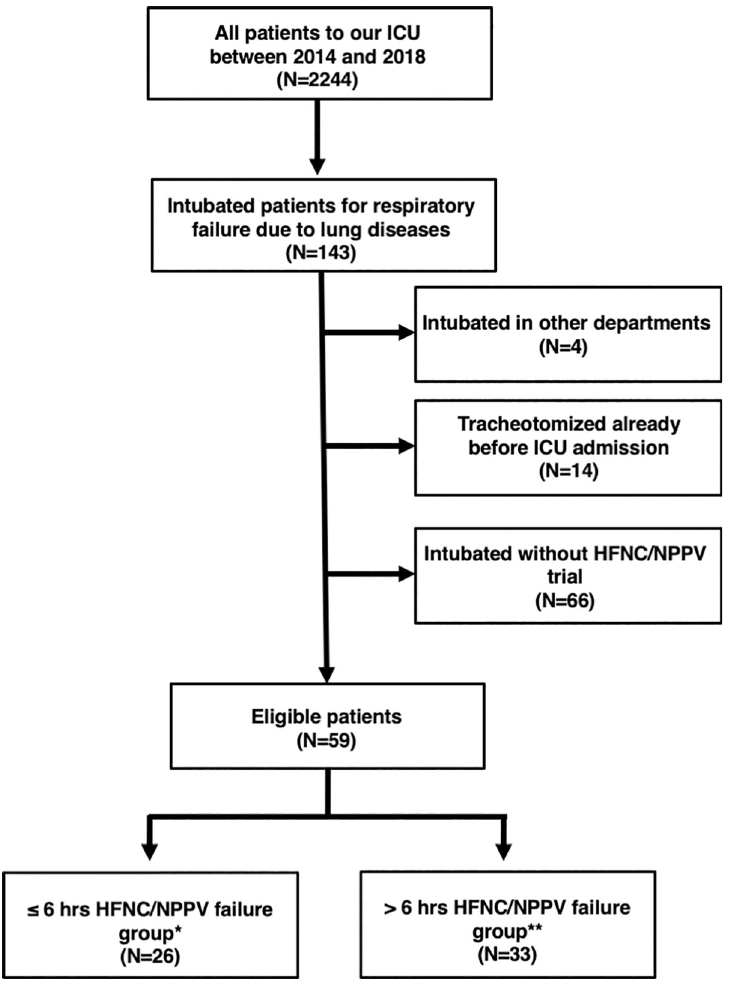
Fig 1. Patients flow. ICU = intensive care unit; HFNC = high-flow nasal cannula; NPPV = noninvasive positive pressure ventilation. � group showing failure of HFNC/NPPV � 6 hours of its initiation. �� group showing failure of HFNC/NPPV > 6 hours after its